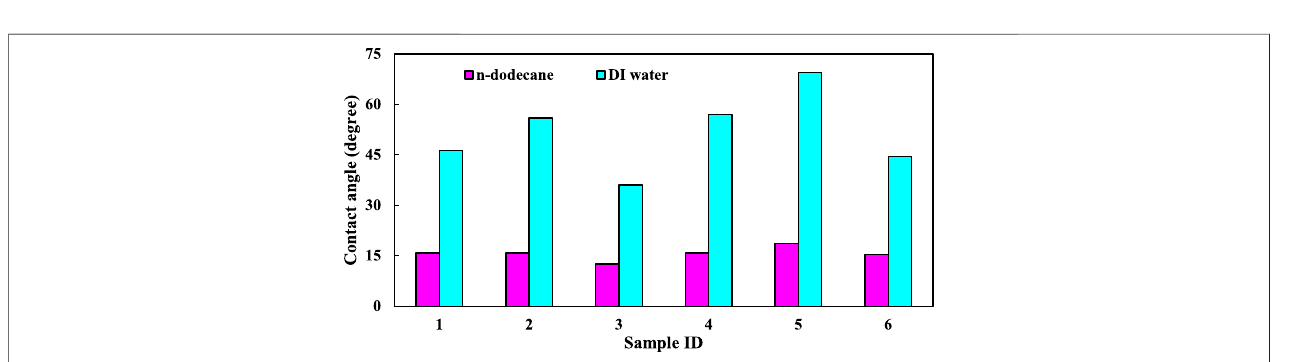
FIGURE 6 | Contact angle measurements for n-dodecane (at 0.02 s) and DIW (at 30 s) liquids.